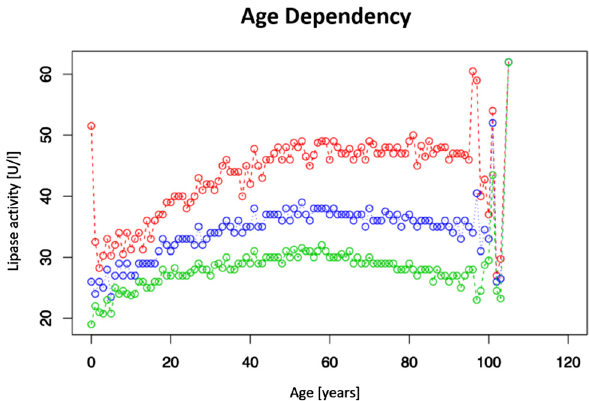
Figure 2: Age dependency (n=29.841, all): 25th (green), 50th (blue) and 75th (red)